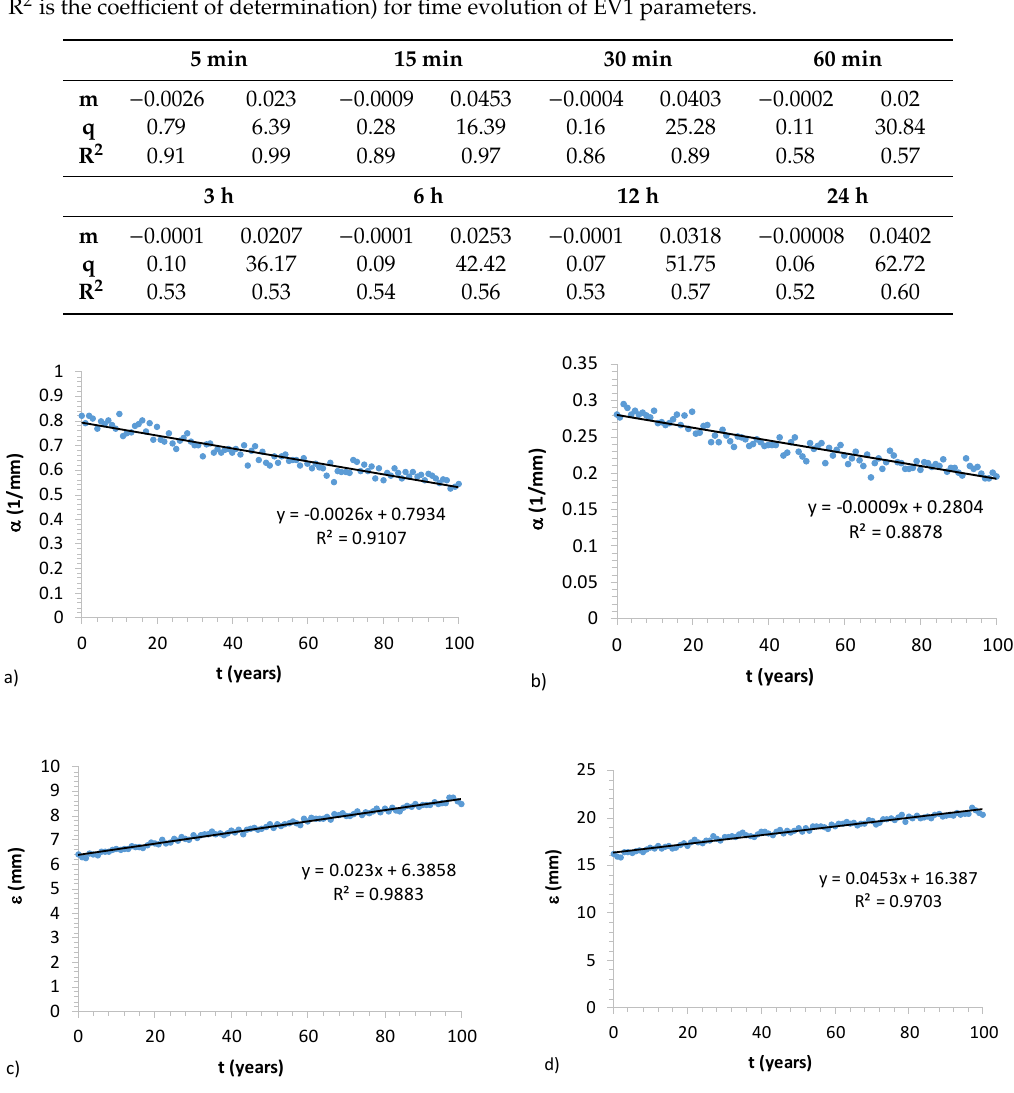
Figure 8. Linear regressions for time evolution of EV1 parameters, for 5-min ( a , c ) and 15-min ( b , d ) AMR synthetic data.